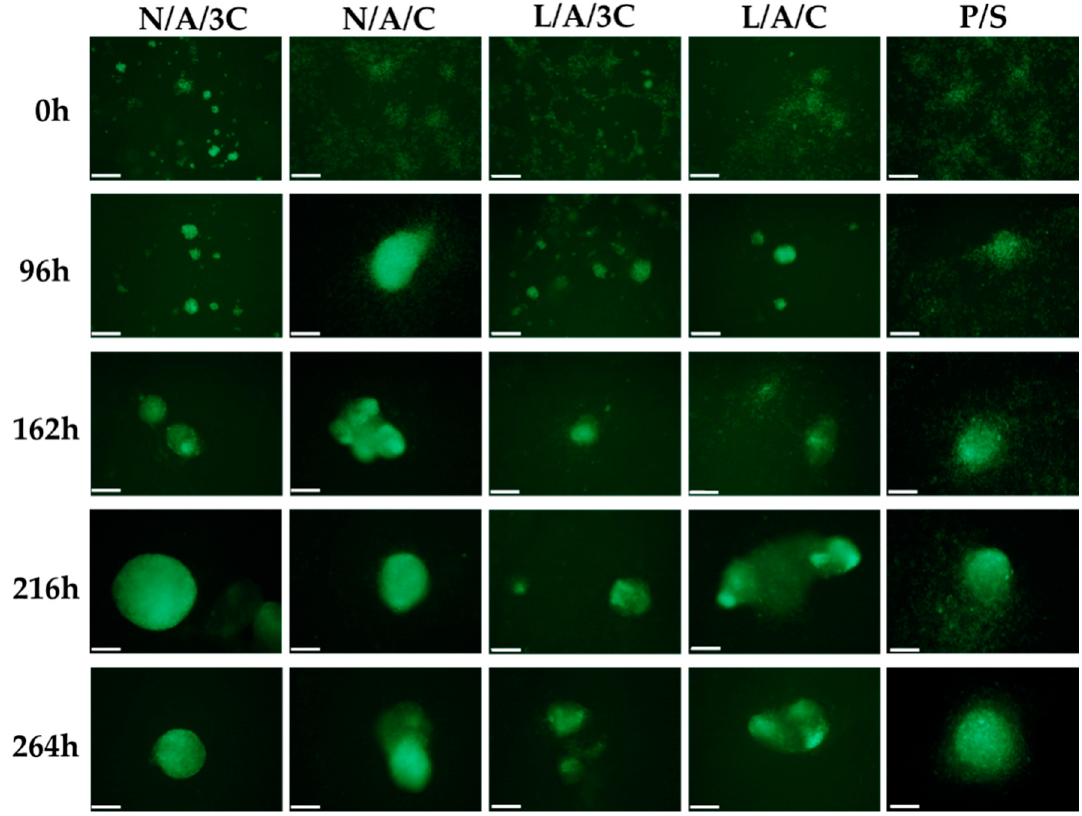
Figure 12. Visualization of nodules development during chondrogenic cultures of hASCs. The morphological changes were monitored during chondrogenesis (from 0 to 264 h of chondrogenic induction). Cell membranes were stained with PKH67 (light green). Magnification used for analysis was 100×. Scale bar equals 200 µm.